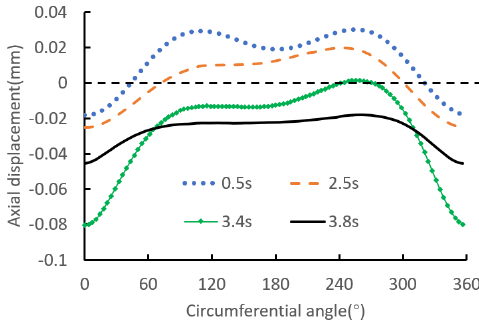
Figure 18. Periodic trend of the axial displacement at point C.